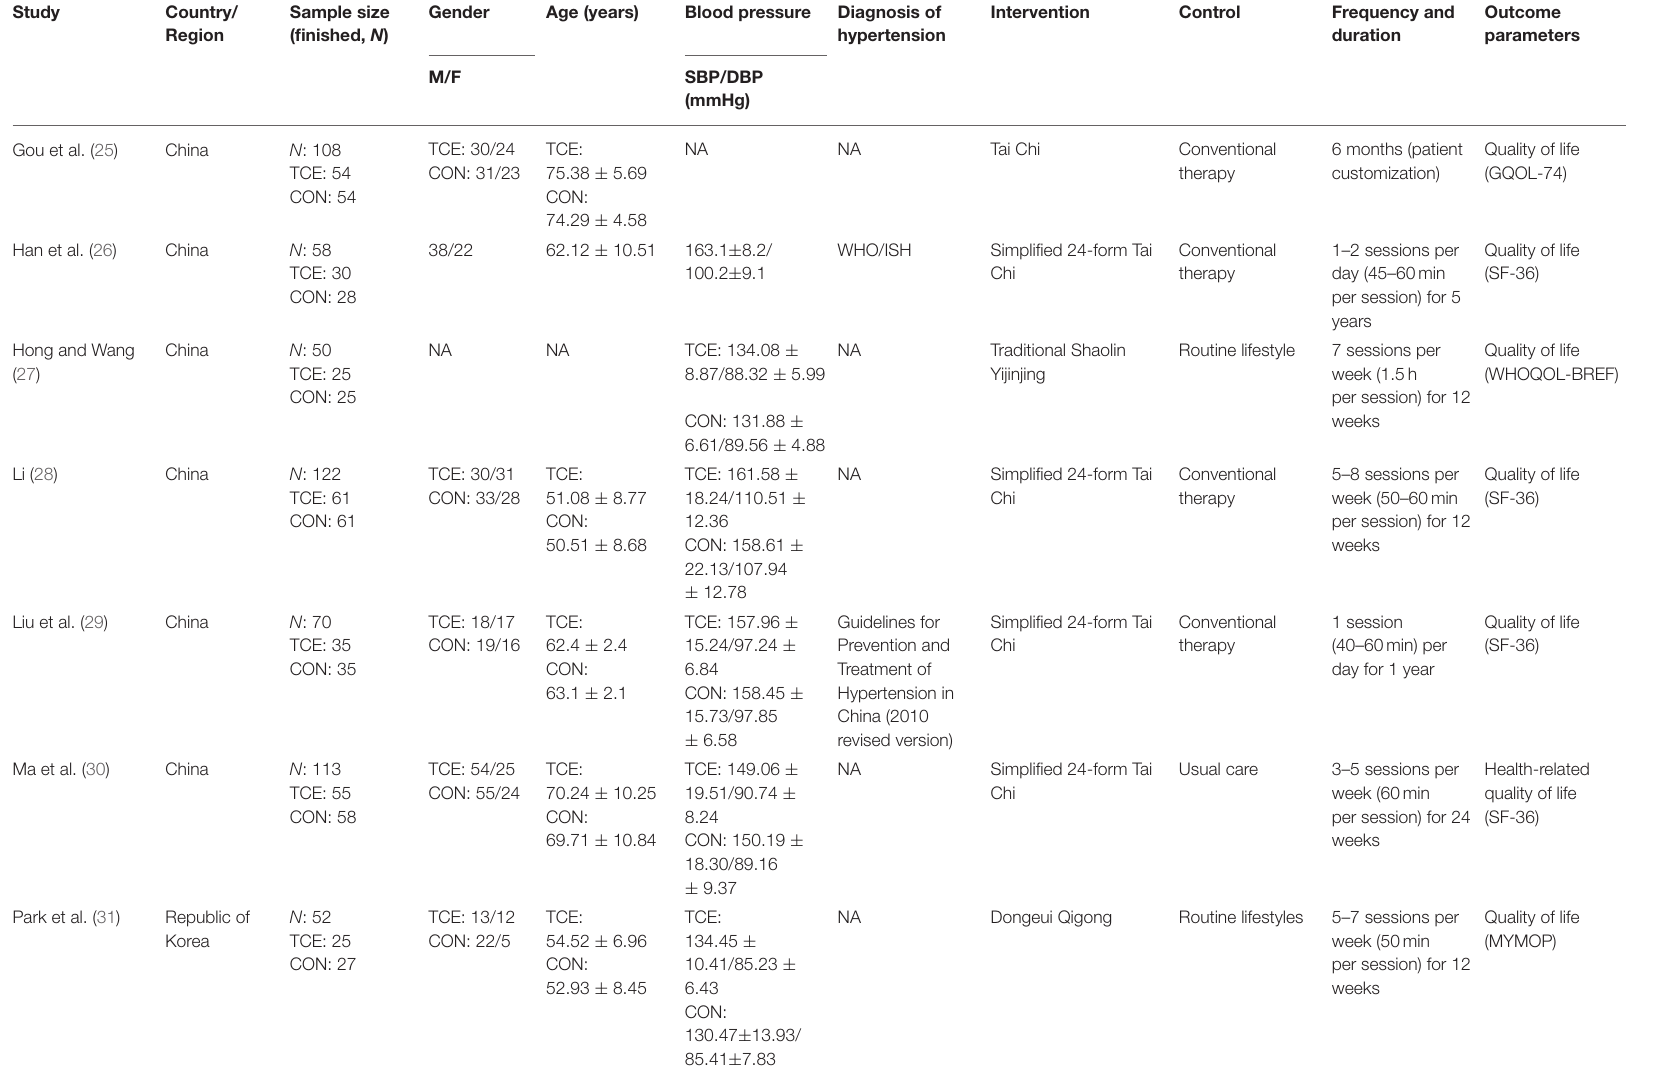
TABLE 2 | The basic characteristics of included studies.